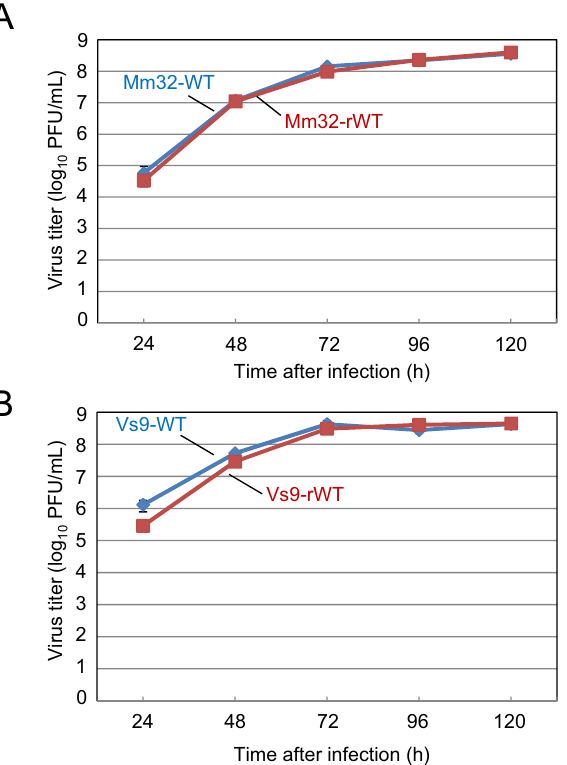
Figure 2. Growth kinetics of the wild-type (WT) and recombinant wild-type (rWT) viruses. MDCK cells were infected with ( A ) Mm32-WT or Mm32-rWT and ( B ) Vs9-WT or Vs9-rWT at an MOI of 0.01. The culture supernatants were collected at the indicated time points, and the viral titers were determined using plaque assays. The results are reported as the mean titers with standard errors of the mean for three independent experiments. The mixed ANOVA indicated no significance of the differences between growth kinetics of ( A ) Mm32-WT dataset vs. rWT (p = 0.814) and ( B ) Vs9-WT vs. rWT (p =